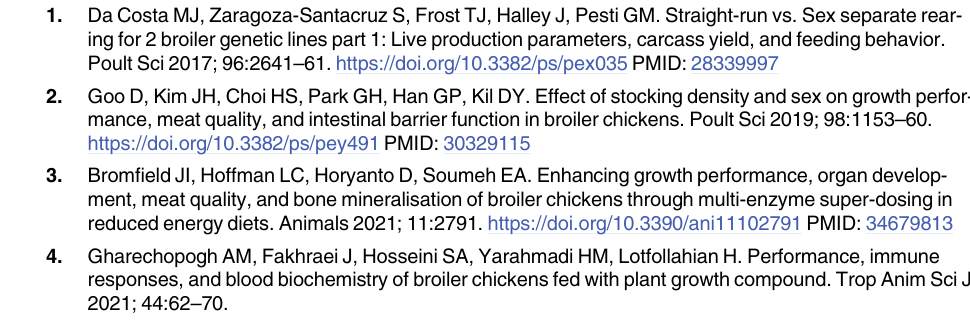
S4 Table. Comparison of grand means and standard error for body weight gain during d 25–35 when data was analysed by ANOVA and ANCOVA in Experiment 2. S5 Table. Comparison of tests of between-subjects effects for body weight gain during d 21–35 when data was analysed by ANOVA and ANCOVA in Experiment 3. S6 Table. Comparison of grand means and standard error for body weight gain during d 21–35 when data was analysed by ANOVA and ANCOVA in Experiment 3. S7 Table. Comparison of tests of between-subjects effects for body weight gain during d 28–35 when data was analysed by ANOVA and ANCOVA in Experiment 4. S8 Table. Comparison of grand means and standard error for body weight gain during d 28–35 when data was analysed by ANOVA and ANCOVA in Experiment